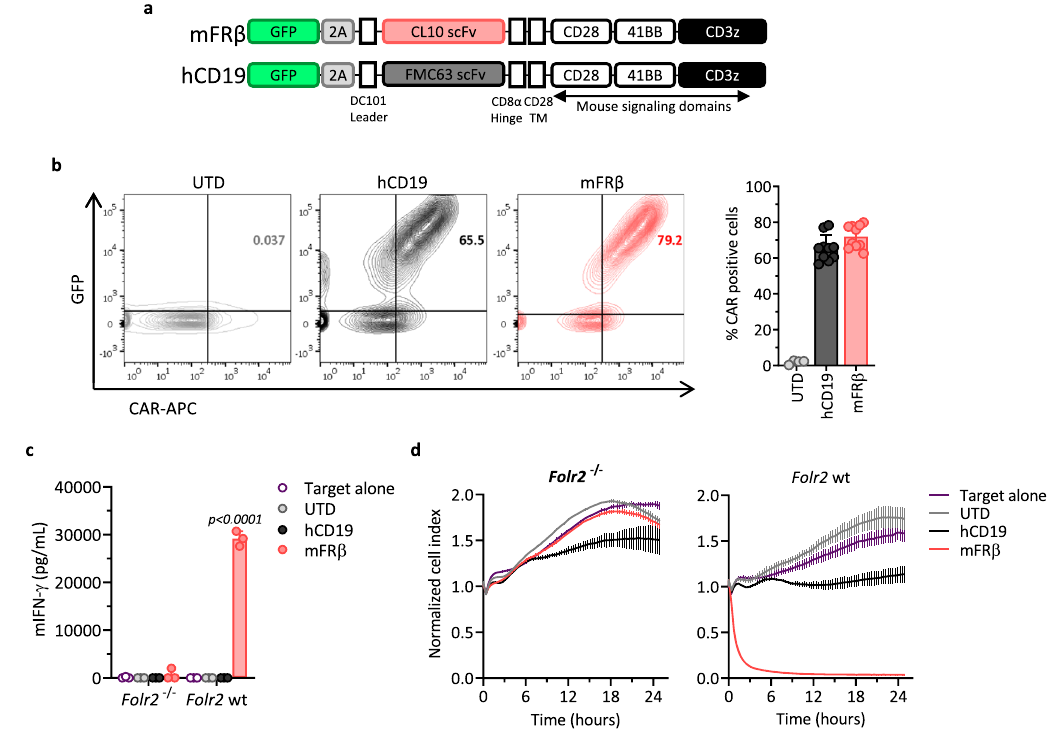
Fig. 4 Mouse FR β CAR-T cells ef fi ciently target FR β + TAMs ex vivo. a Schematic representation of retroviral CAR constructs containing the rat anti- mouse FR β (mFR β ) scFv (CL10) or the mouse anti-human CD19 (hCD19) scFv (FMC63), linked to the mouse intracellular signaling domains CD28, 41BB, and CD3 ζ in tandem. Both constructs also include GFP as a transduction marker. b Expression of hCD19 and mFR β CARs in the surface of transduced mouse T cells as detected by staining with biotinylated goat anti-mouse IgG (H + L) or rabbit anti-human IgG (H + L), respectively, followed by streptavidin (SA)-APC labeling at day 5 of T cell expansion. CAR + cells were de fi ned as double positive for GFP ( Y -axis) and APC ( X -axis). Representative fl ow plots (left panel) and mean frequencies of CAR + T cells (pregated on live/CD3 + , right panel)± SD are shown ( n = 10). Each symbol represents an independent T cell expansion. Cocultures of mFR β CAR, hCD19 CAR, or UTD T cells with CD11b + cells obtained from ID8 tumor-bearing Folr2 wt or Folr2 − / − mice were established at a 1:1 E:T ratio. c Levels of secreted mIFN- γ as detected by ELISA in the supernatants at 24h. d Real-time cytotoxicity assays performed using xCelligence technology. c , d Mean± SD of triplicates is represented. P values by a two-way ANOVA with Tukey ’ s multiple comparison test are indicated. Source data are provided in the Source Data fi